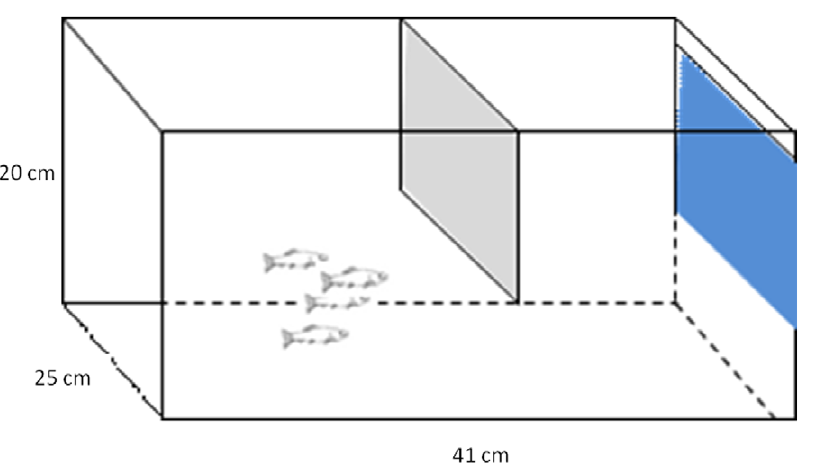
Figure 1. The testing tank arena used for this study. We used 5 gallon aquaria (18.9 L) which are 16 0 6 8 0 6 10 0 (41 6 20 6 25 cm).The testing tank was partially divided by a central plastic plate that left enough room at the bottom to allow fish to swim back and forth between the two sides.